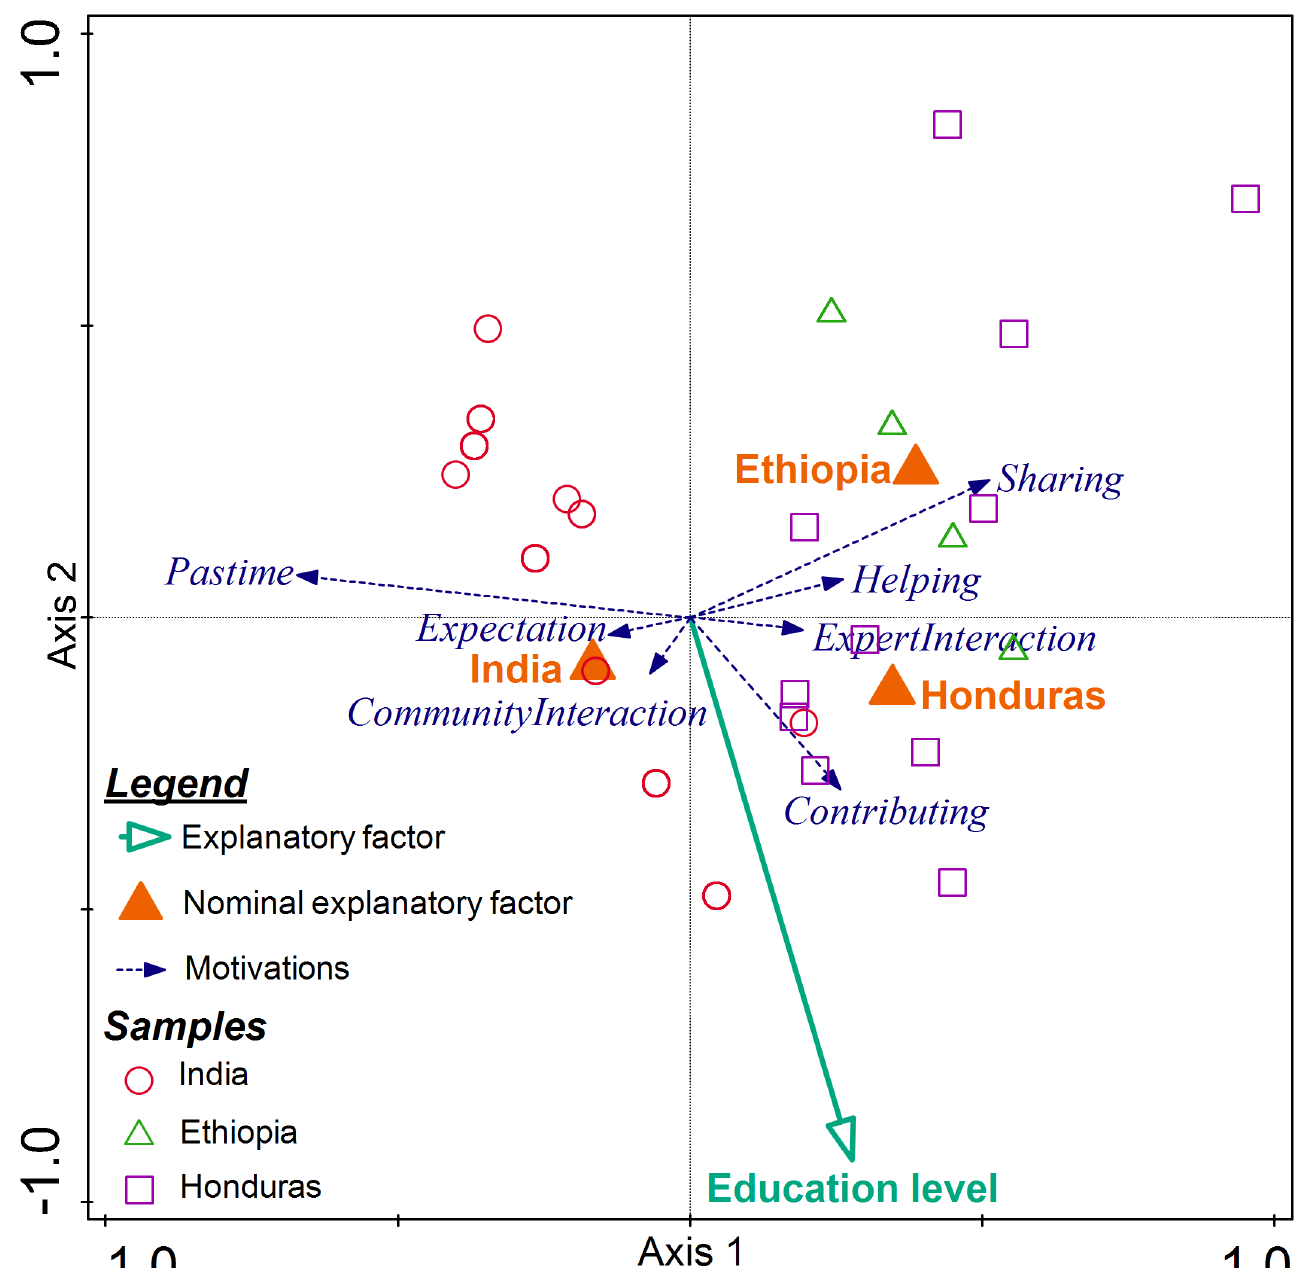
Fig 4. Triplot diagram showing the result of the RDA analysis of motivational factors and farmers’characteristics together with samples from the three countries. The blue (dashed)vectors represent motivational factors, green (solid) vector denotesthe explanatory factor, education level and triangles(filled) representthe nominalexplanatory